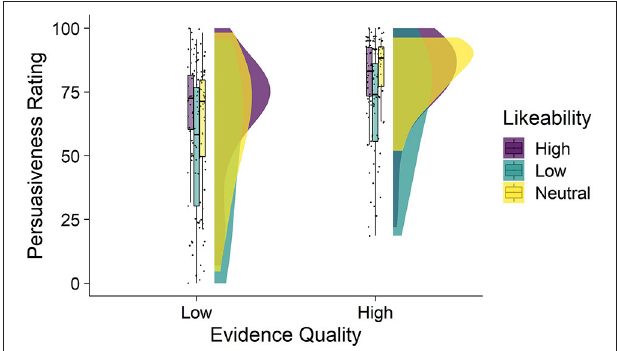
FIGURE 2 | Persuasiveness as a function of expert evidence quality and likeability (Study 2). Figure depicts four raincloud plots showing the distribution of persuasiveness ratings observed in each condition. From left to right, each raincloud plot depicts the: jittered individual data points, box-and-whisker plots (middle bar within the box is the median, the box represents the interquartile range of persuasiveness ratings, and the whiskers represent persuasiveness ratings no further than 1.5 × the interquartile range), and the distributions showing the frequency of persuasiveness ratings. Mean persuasiveness ratings differed by evidence quality and likeability conditions.